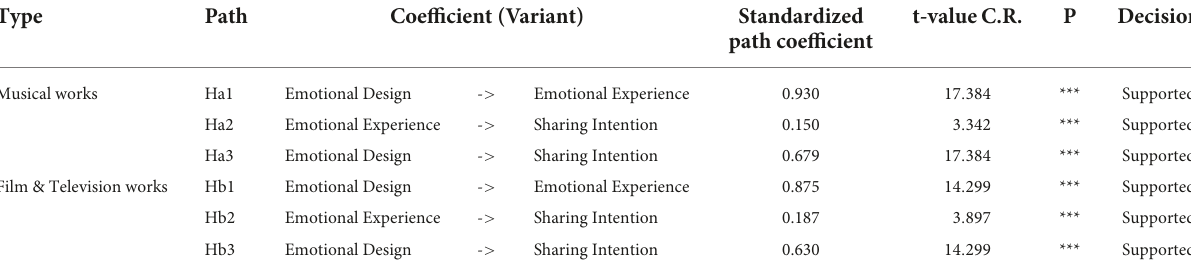
TABLE 6 Path coefficient of structural statistical